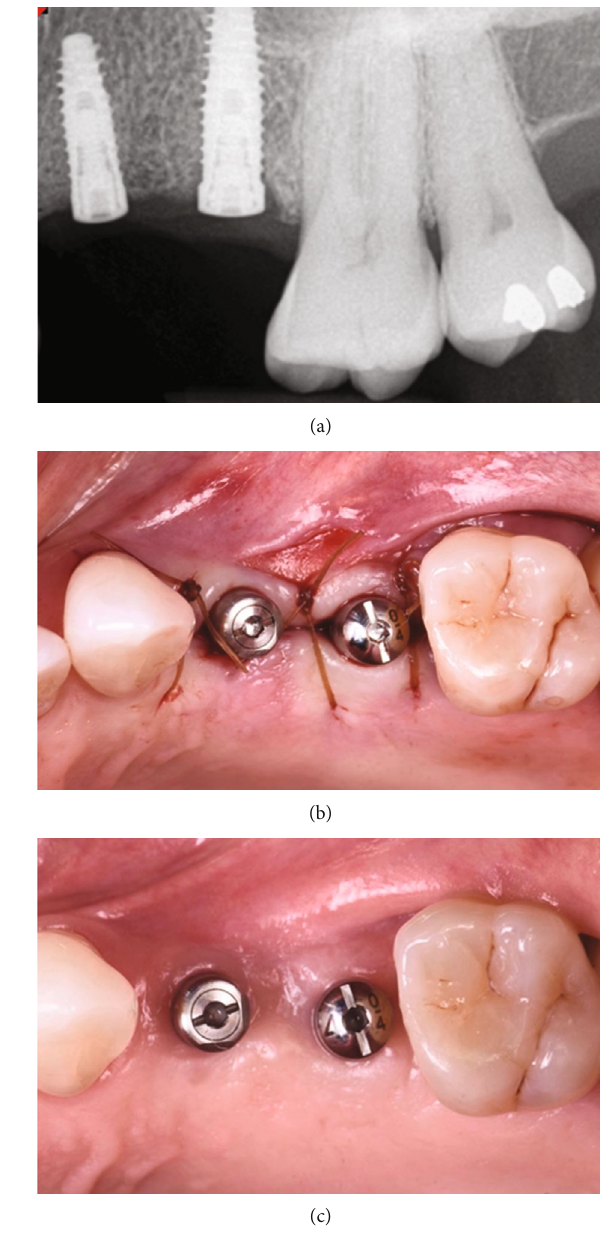
Figure 5: (a) Eight days of follow-up presented with exaggerated tissue response to the surgery. (b) Four weeks postoperative with better soft tissue response. (c) Eight weeks postoperative with thin, soft tissue covering the implants.